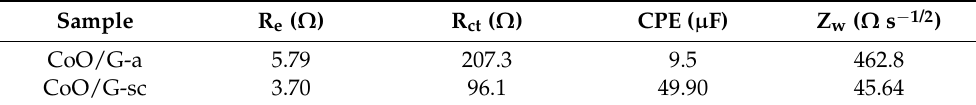
Figure 6. ( a ) Nyquist plots for CoO/G-a and CoO/G-sc after 5 cycles (inset: Equivalent circuit used to fit the experimental data), ( b ) Z’ vs. ω − 1/2 plot in the low frequency region of CoO/G-a and CoO/G-sc electrodes. Table 1. Values of equivalent resistance used for fitting the experimental